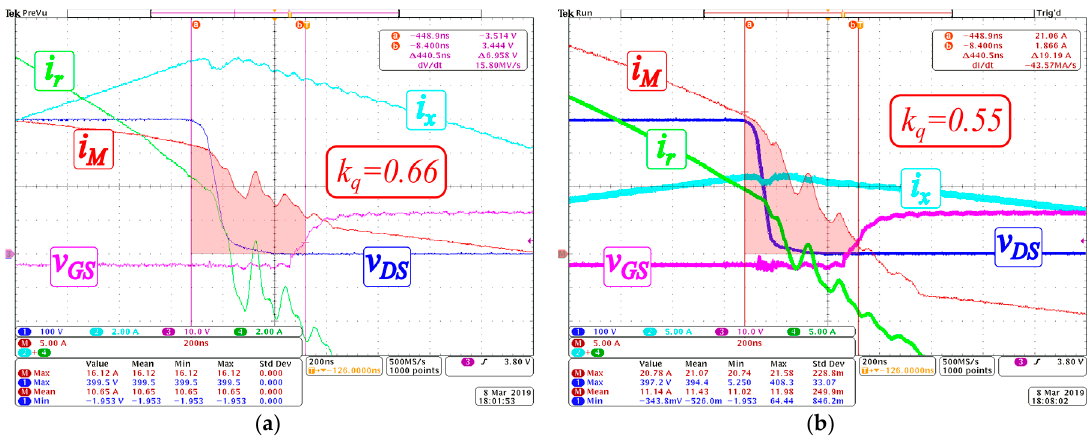
Figure 25. ( a ) Measurement setup including auxiliary circuit; ( b ) ZVS experimental results at 500 W.